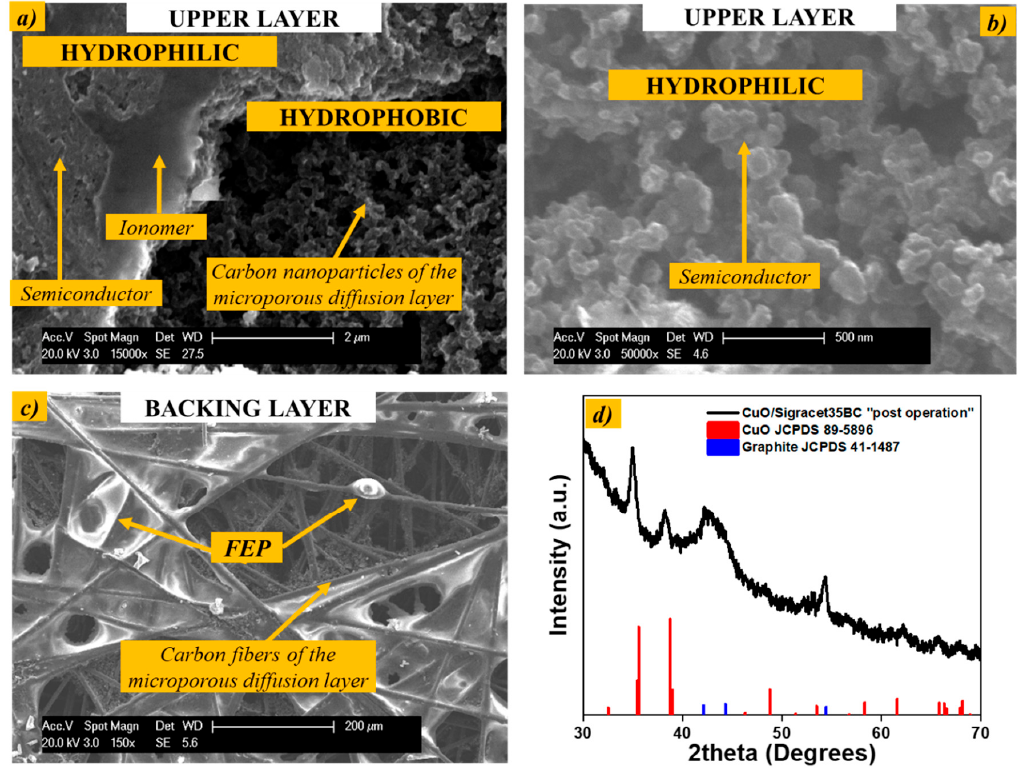
Figure 10. Post operation SEM images of the CuO semiconductor deposited on a Sigracet 35BC ® gas diffusion layer containing 7 wt% FEP: upper layer ( a , b ), backing layer ( c ). Post-operation X-ray diffraction analysis of the photocathode ( d ).